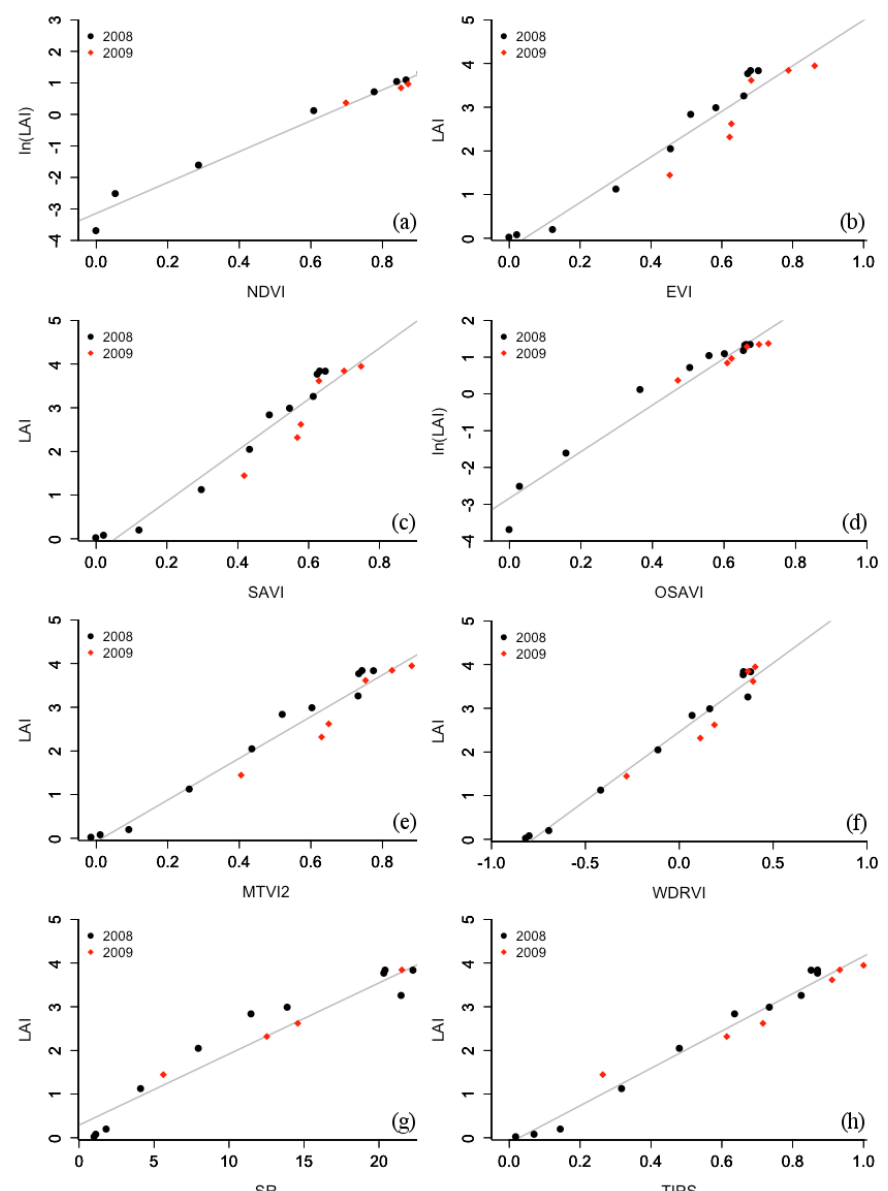
Figure 2. Relationship between LAI and each vegetation index in 2008 and 2009. ( a ) NDVI; ( b ) EVI; ( c ) SAVI; ( d ) OSAVI; ( e ) MTVI2; ( f ) WDRVI; ( g ) SR; ( h )